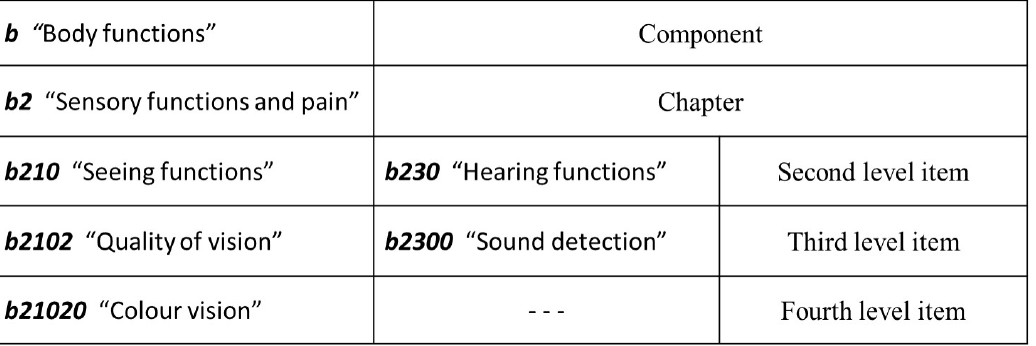
Figure 1. An excerpt of the International Classification of Functioning, Disability and Health (ICF) classification illustrating the deepening of a component into two different health-related functions.